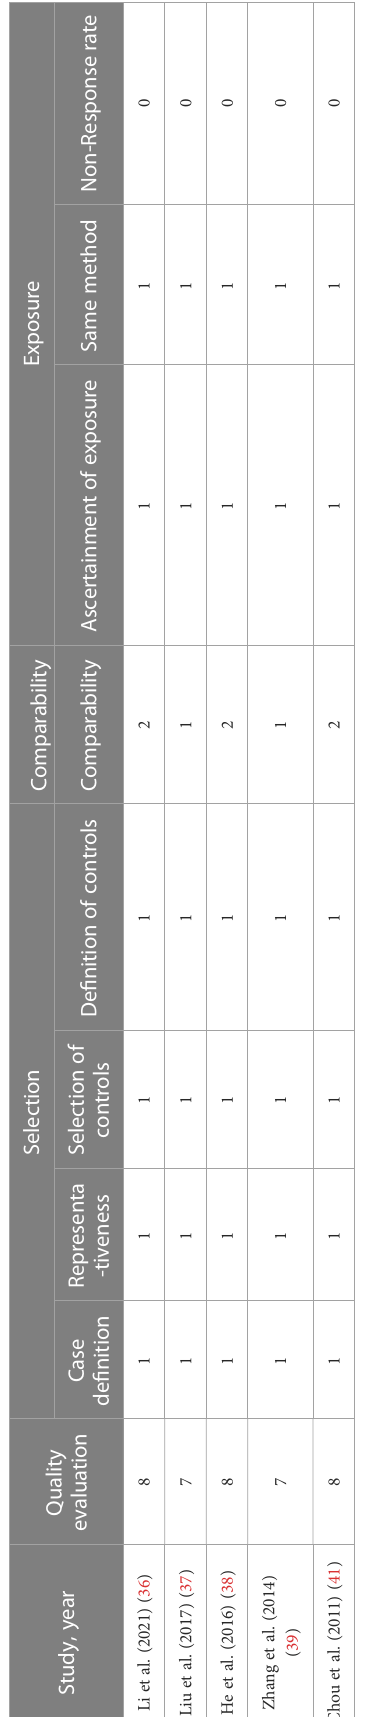
(Table 4; Supplemental Figure 5).